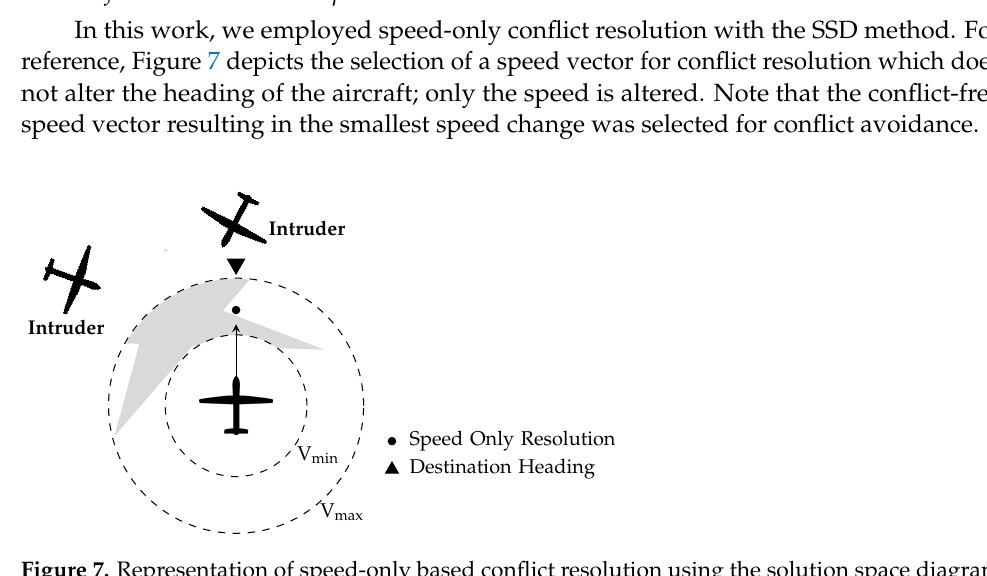
Figure 7. Representation of speed-only based conflict resolution using the solution space diagram (SSD)